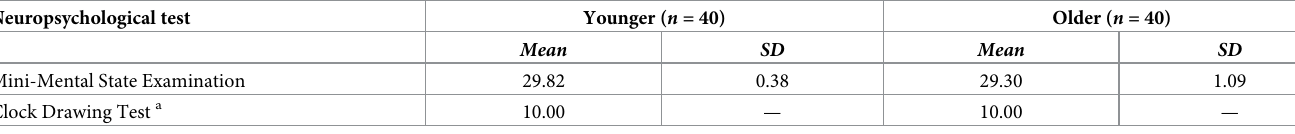
Table 1. Results of neuropsychological tests. Neuropsychological